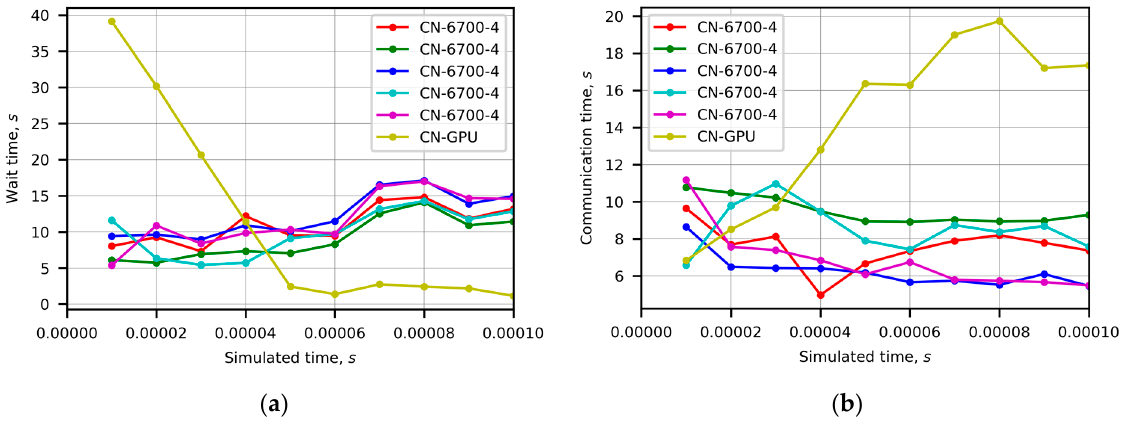
Figure 4. Time evolution of wait time ( a ) and communication time ( b ) in Case 3.